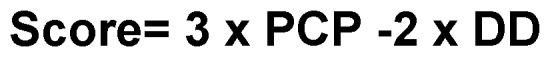
Formula to obtain the PROCONSUL score.PCP = pattern of clinical presentation: assign 0 if non classical/asymptomatic and 1 if classical; DD = diagnostic delay: assign 0 if <6 months and 1 if >6 months.